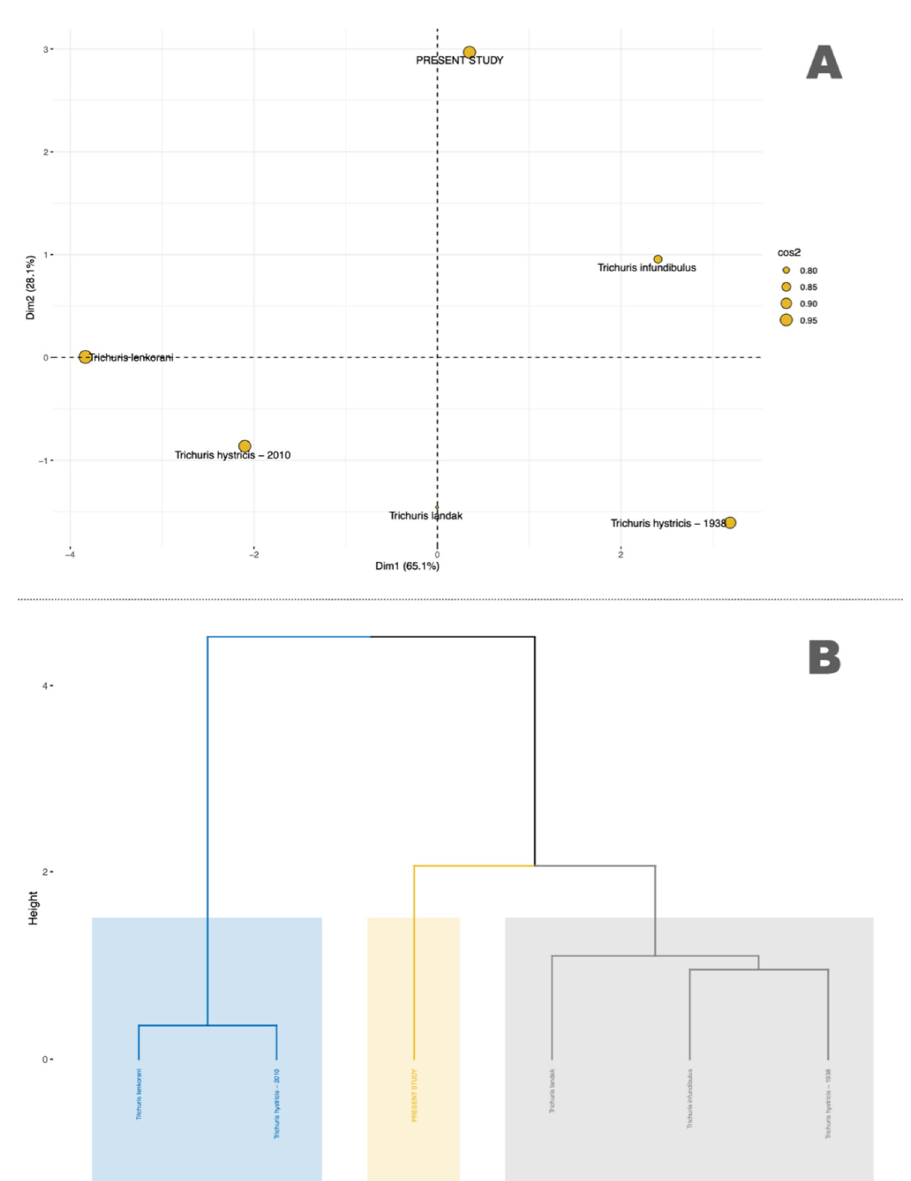
Figure 2. ( A ) Principal component analysis and ( B ) HCPC cluster dendrogram based on Trichuris sp. morphological traits (dataset II), alongside with other Trichuris spp. used for comparative pur- poses.